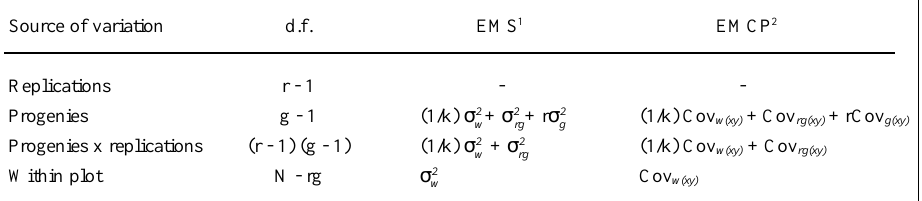
Table I - Degrees of freedom (d.f.), expected mean square (EMS) and expected mean covariance product (EMCP) for estimating components of variance, covariance and heritabilities in an open-pollinated progeny test of rubber tree ( Hevea brasiliensis